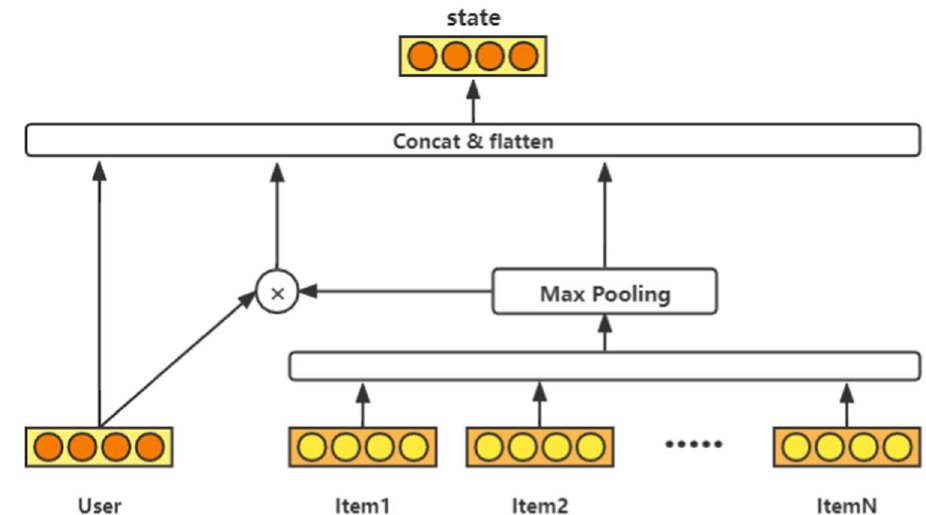
Fig. 1 State generation